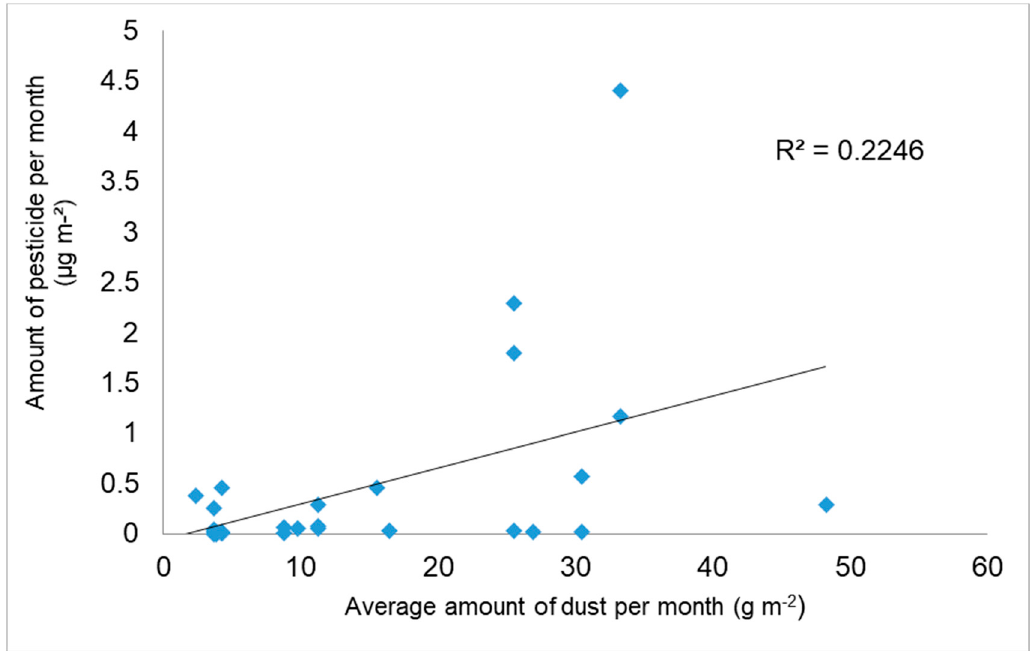
Figure A3. Correlation between the amount of pesticide per month ( µ g m − 2 ) and the amount of dust per month (g m − 2 ).